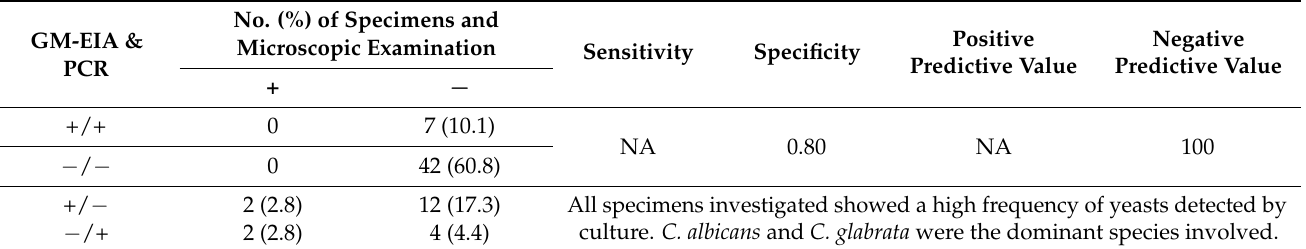
Table 2. Aspergillus sp. culture-negative specimens ( n = 69) analyzed via direct microscopy (gold standard), Aspergillus PCR, and galactomannan enzyme immunoassay testing